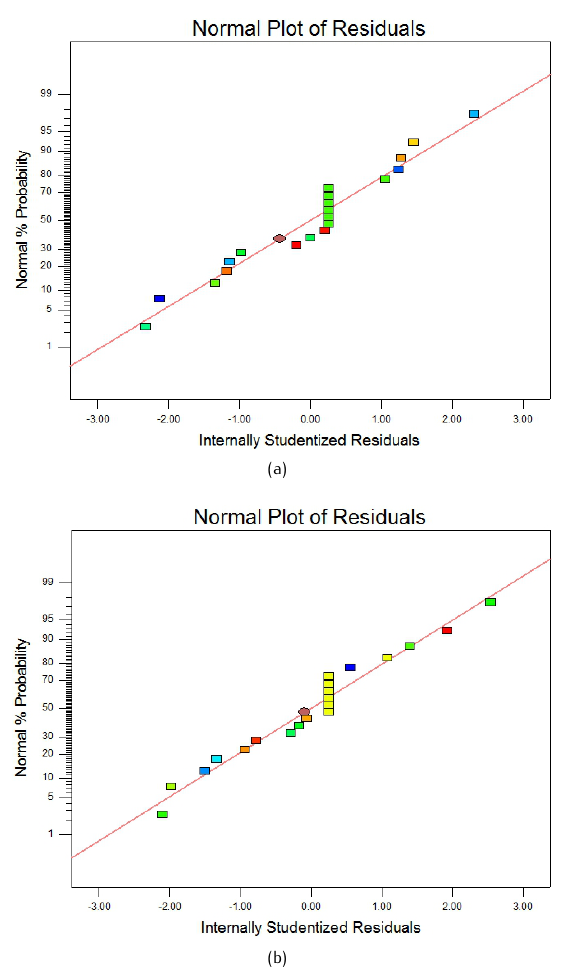
Figure 1. The studentized residuals and normal % probability plot of bio decolourization of RTB (a) and RB5 (b) dyes.